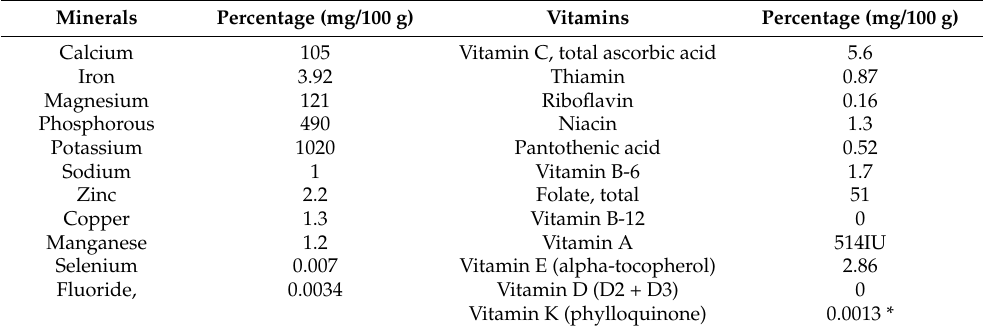
Table 2. Pistachio (raw, unsalted) micronutrient content.